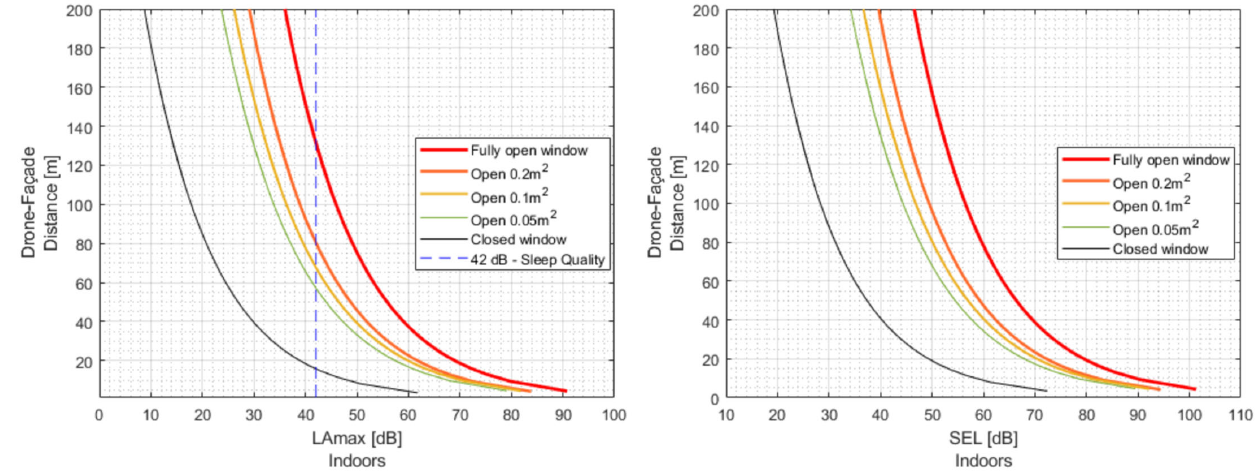
Figure 11. Recommended drone/façade distance for the drone Typhoon based on LA max , indoors ( left ) and SEL indoors ( right